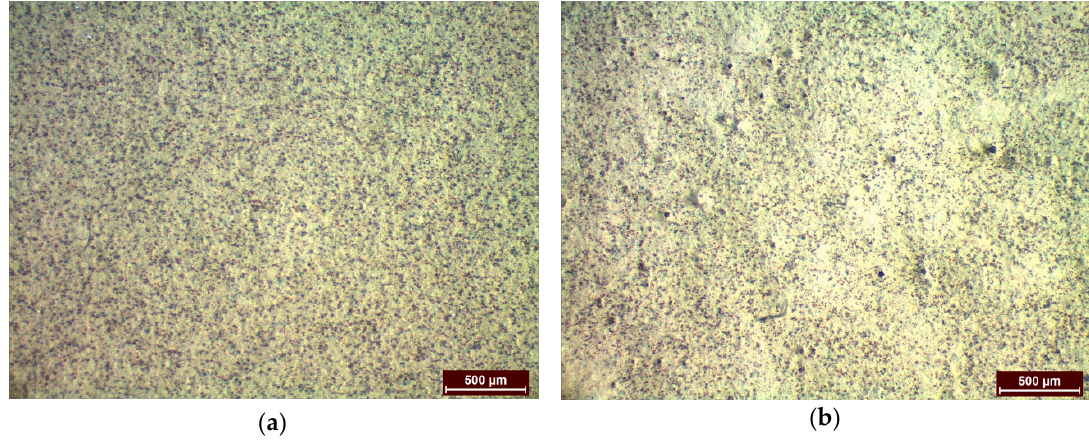
Figure 11. Stereoscopical view of the coated specimens ( a ) without NPs and ( b ) with dispersed Econea-loaded